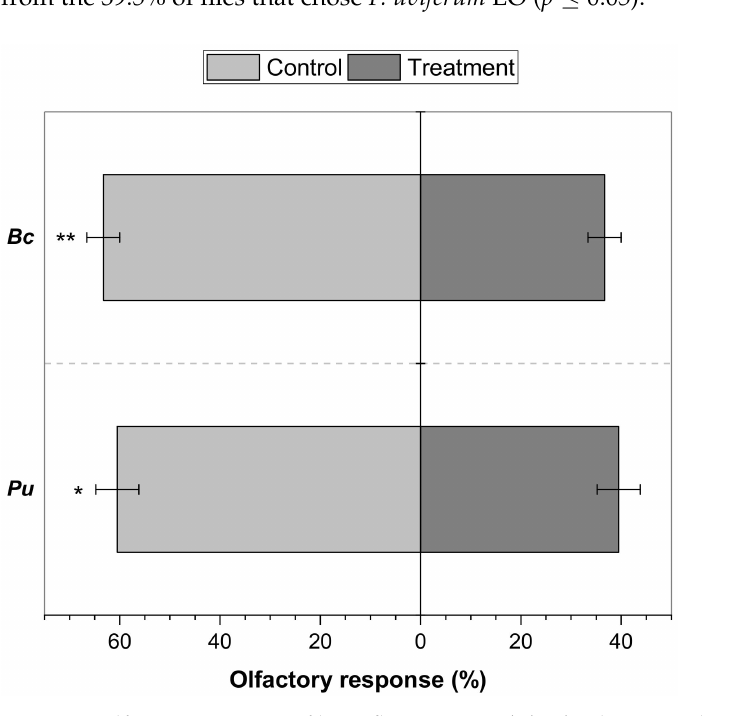
Table 2. Toxicological activity of B. cruckchanksii leaves and P. uviferum heartwood essential oils against horn flies. EO